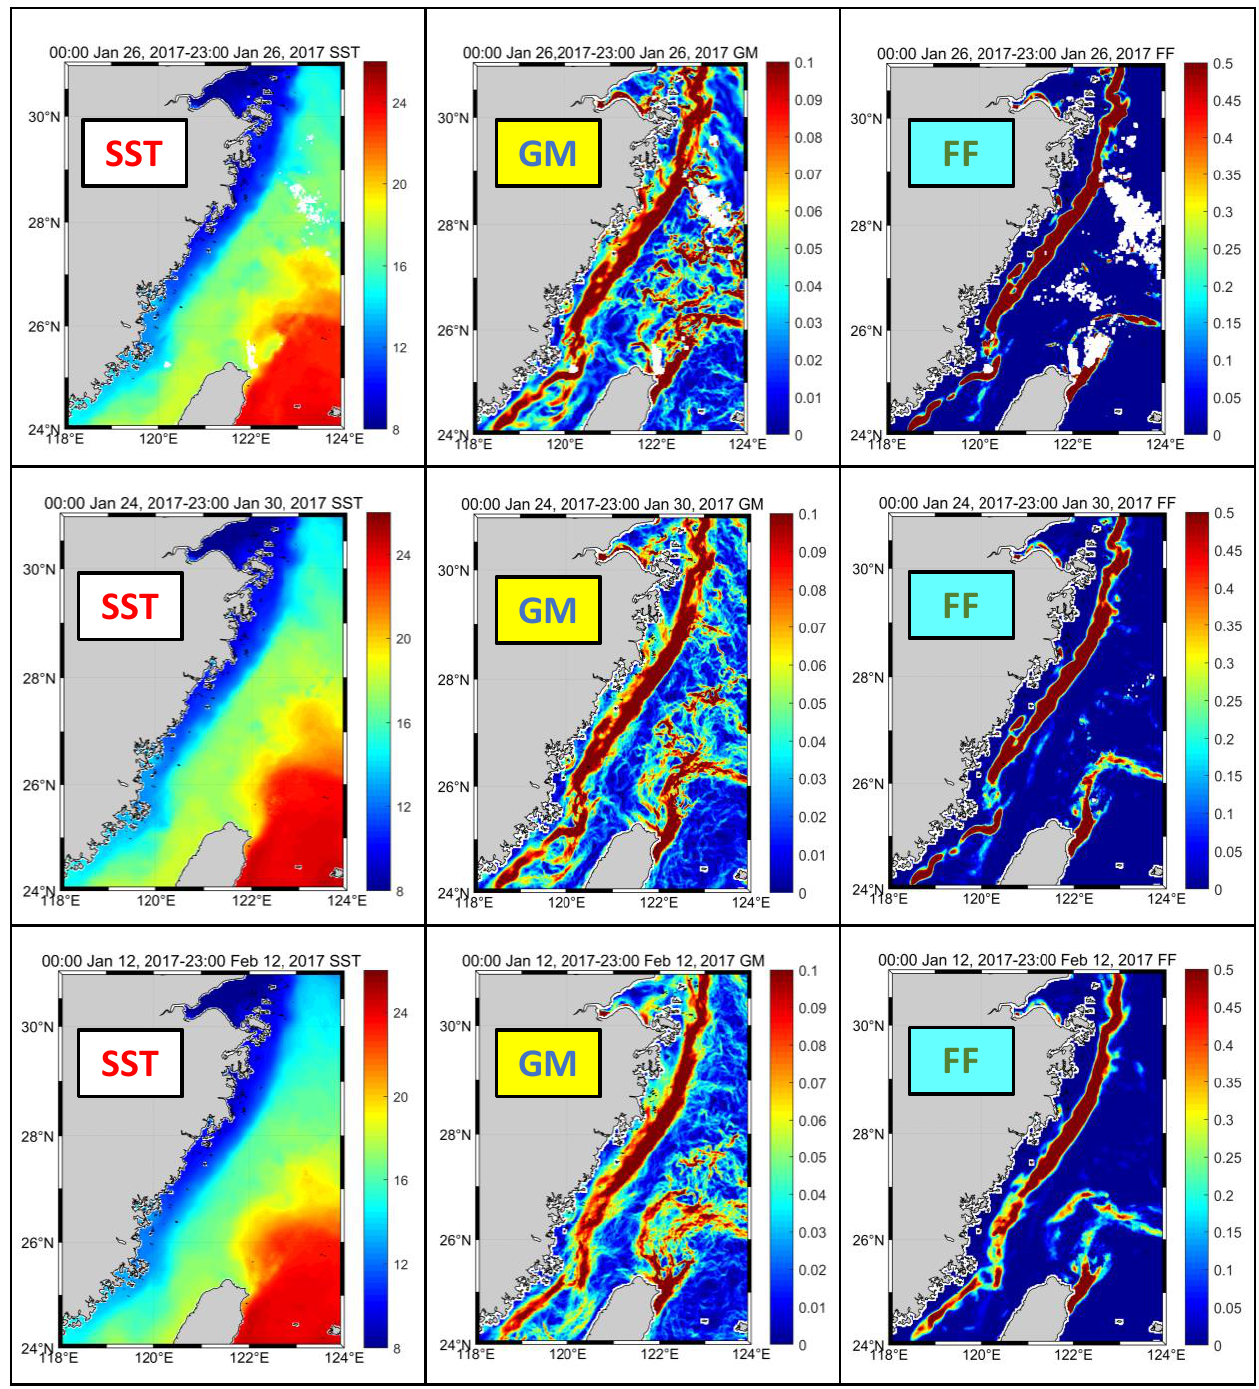
Figure 2. Sample datasets illustrating daily (top row), weekly (middle row), and monthly (bottom row) data. Each dataset consists of SST (°C, left), SST gradient magnitude GM (°C/km, center), and frontal frequency FF at GM ≥ 0.1 °C/km (right). In order to show fine (submesoscale) fronts, the GM color scale is cut off at 0.1 °C/km; peak values of GM at some grid points could be much higher (up to 0.4 °C/km).